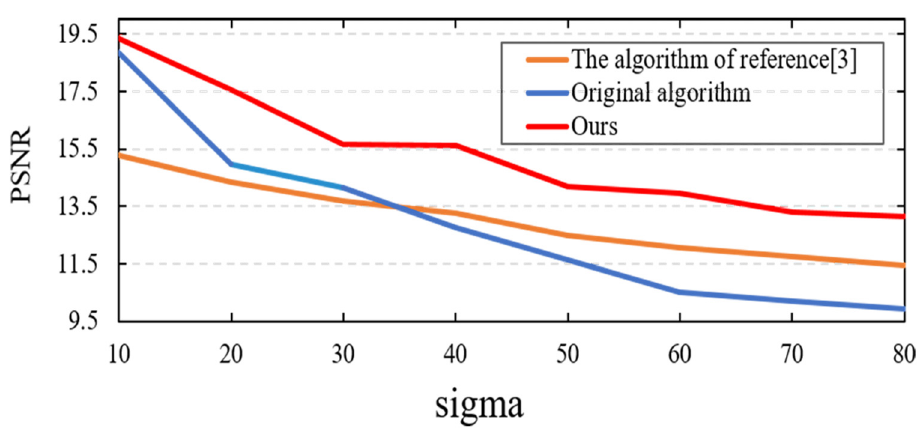
Figure 3. PSNR line chart of the three algorithms for the Cameraman image.